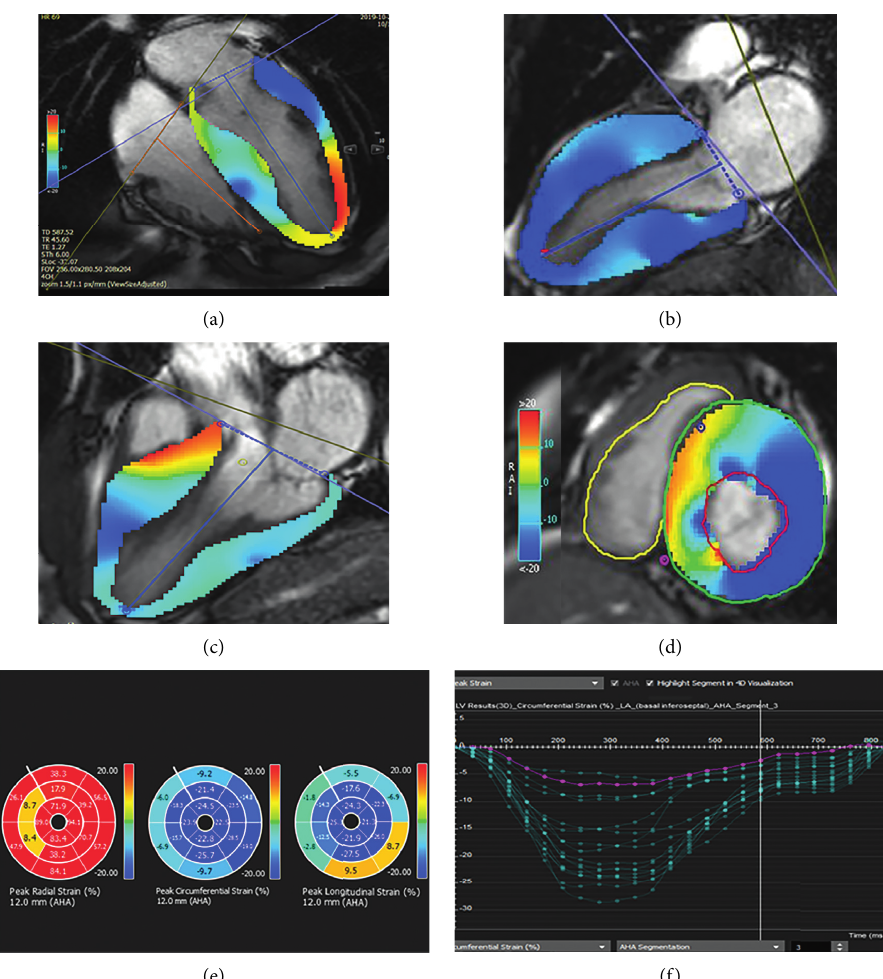
Figure 1: CMR feature-tracking technique for determining myocardial strain. (a) Four-chamber, (b) two-chamber, (c) three-chamber, and (d) short-axis images depict left ventricle endocardial (red) and epicardial (green) borders. (e) Bull’s eye maps and (f) strain curves according to AHA myocardial